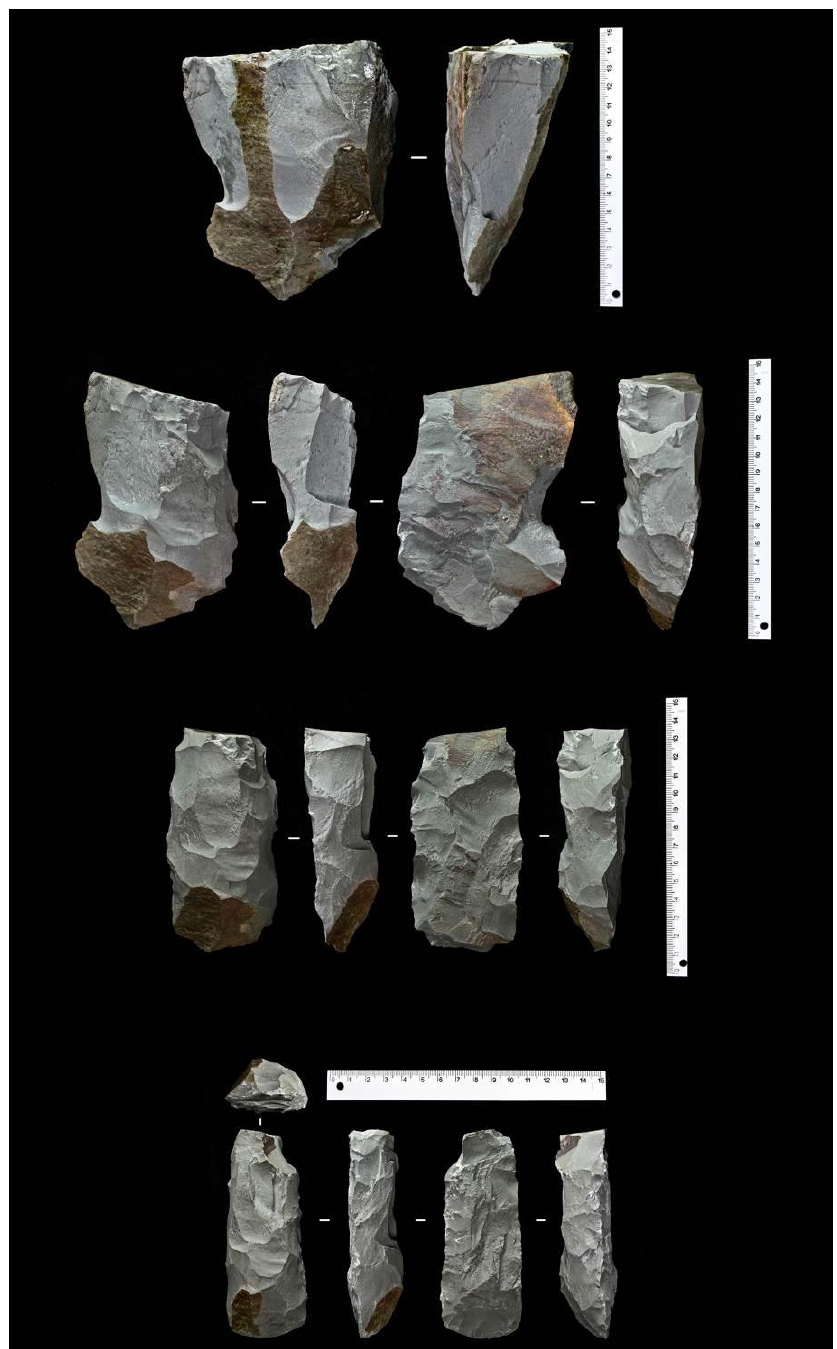
Figure 7. Experimental modelling of the Russian Karelian technology, reduction sequence of making an adze